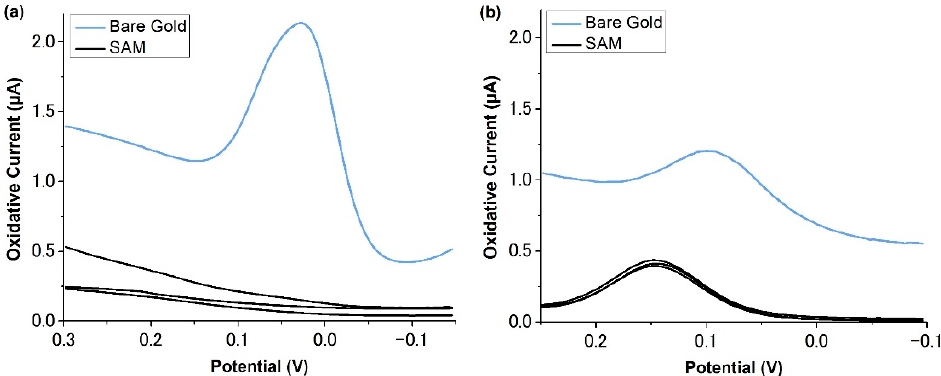
Figure 3. SWVs of ( a ) 25 uM PAP on a bare gold disk electrode and three different disk electrodes modified with a 3-mercaptopropanol SAM and ( b ) 25 uM FcMeOH on a bare gold disk electrode and three different disk electrodes modified with a 3-mercaptopropanol SAM.